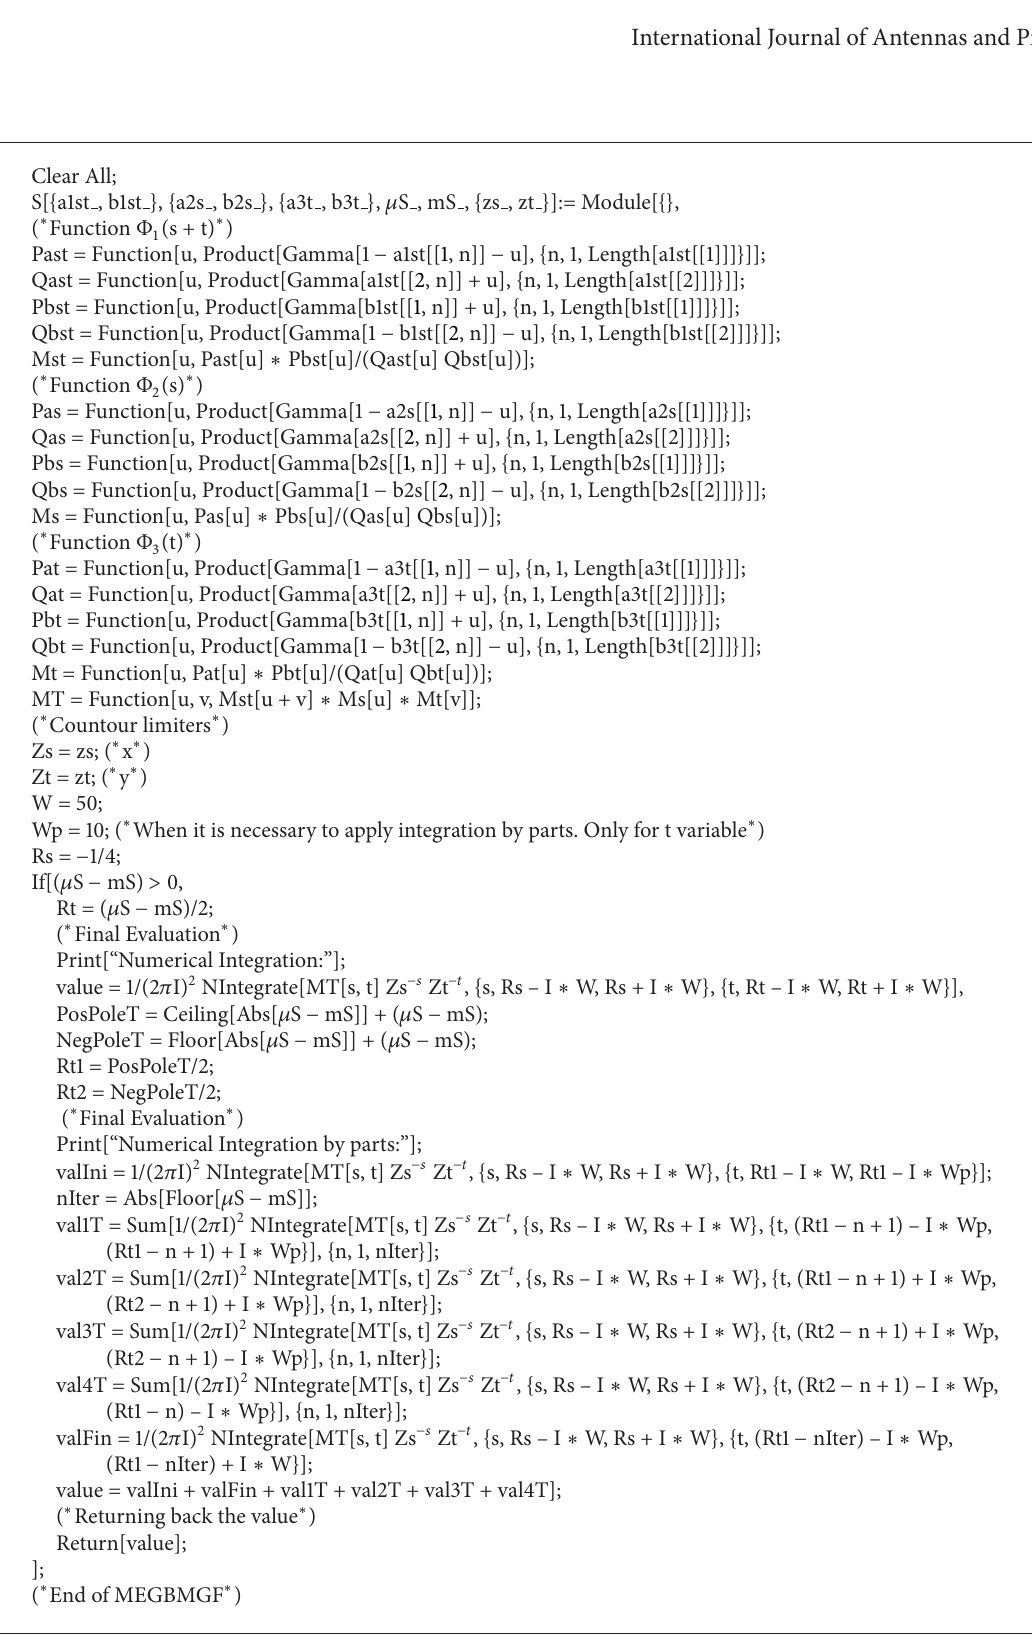
Algorithm 1: Implementation of the bivariate Meijer 𝐺 -function in Mathematica software ( ∗ modification of the EGBMGF [18] to conform the 𝜅 - 𝜇 shadowed model ∗